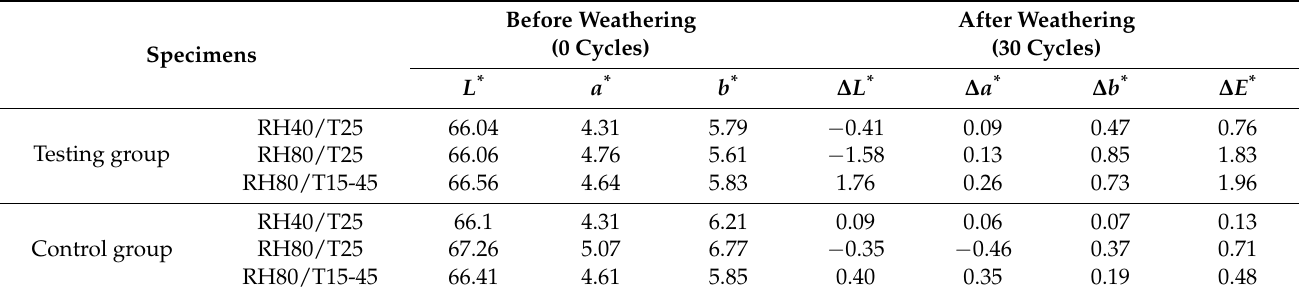
Table 5. Changes in color parameters after artificially accelerated weathering